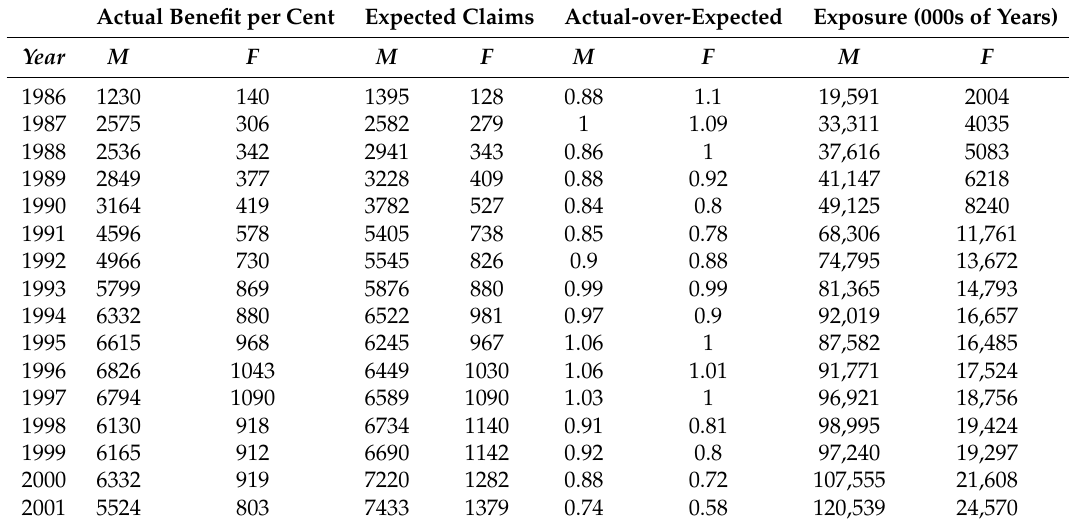
Table 1. Yearly breakdown of the DII insurance data used in the